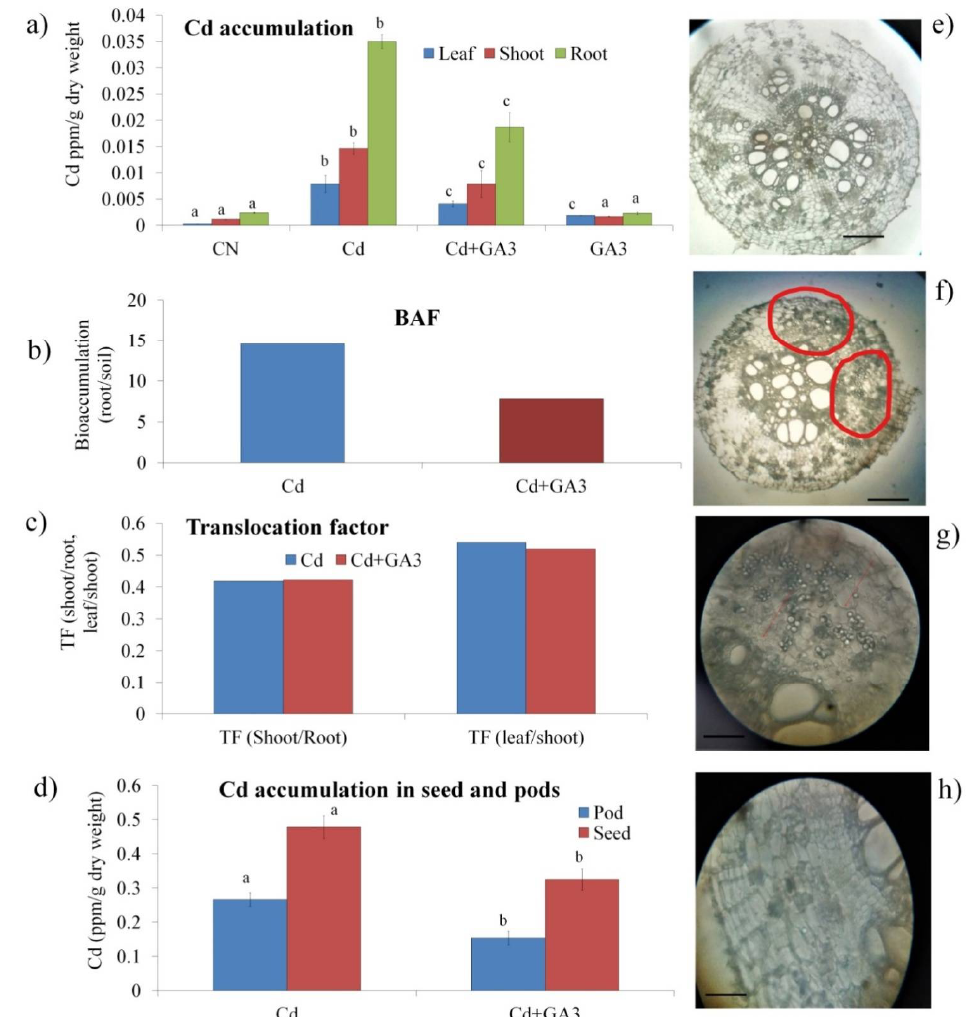
Figure 4. Effect of GA 3 on accumulation, translocation, and localization of cadmium (Cd) in mung bean plants. Effect of GA 3 on cadmium (Cd) accumulation (ppm/g dry weight) in leaf, shoot, and root tissue ( a ), bioaccumulation factor (BAF, Cd accumulation root/soil) ( b ), translocation factor (shoot/root and leaf/shoot) ( c ), Cd accumulation (ppm/g dry weight) in pods and seeds ( d ), and histological localization of Cd ions as Cd-oxalate white crystals in stem tissue transverse sections, Cd alone ( f , g ) and GA 3 pus Cd ( e , h ) of mung bean plants grown in soil in pots at time of harvest. Control (CN), cadmium (Cd) stress, Cd+ gibberellins (GA 3 ), and GA 3 alone conditions. Data presented are means ± standard errors ( n = 10, biological replicates) for ( a – c ). Scale bars: 1000 µ m for ( e , f ) and 100 µ m for ( g , h ). Red circles and red arrows represent the localization of Cd oxalate crystals. Different letters (a, b, c) indicate significant differences from control in all combinations (Tukey’s test, p ≤